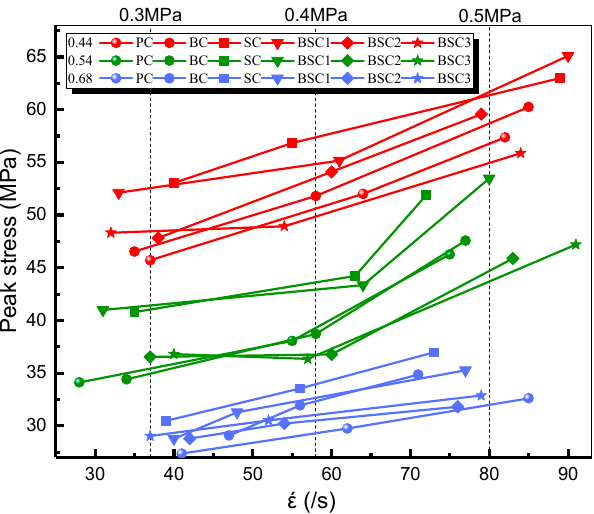
Figure 12. Strain rate e ff ect on the peak stress of BSFRC.